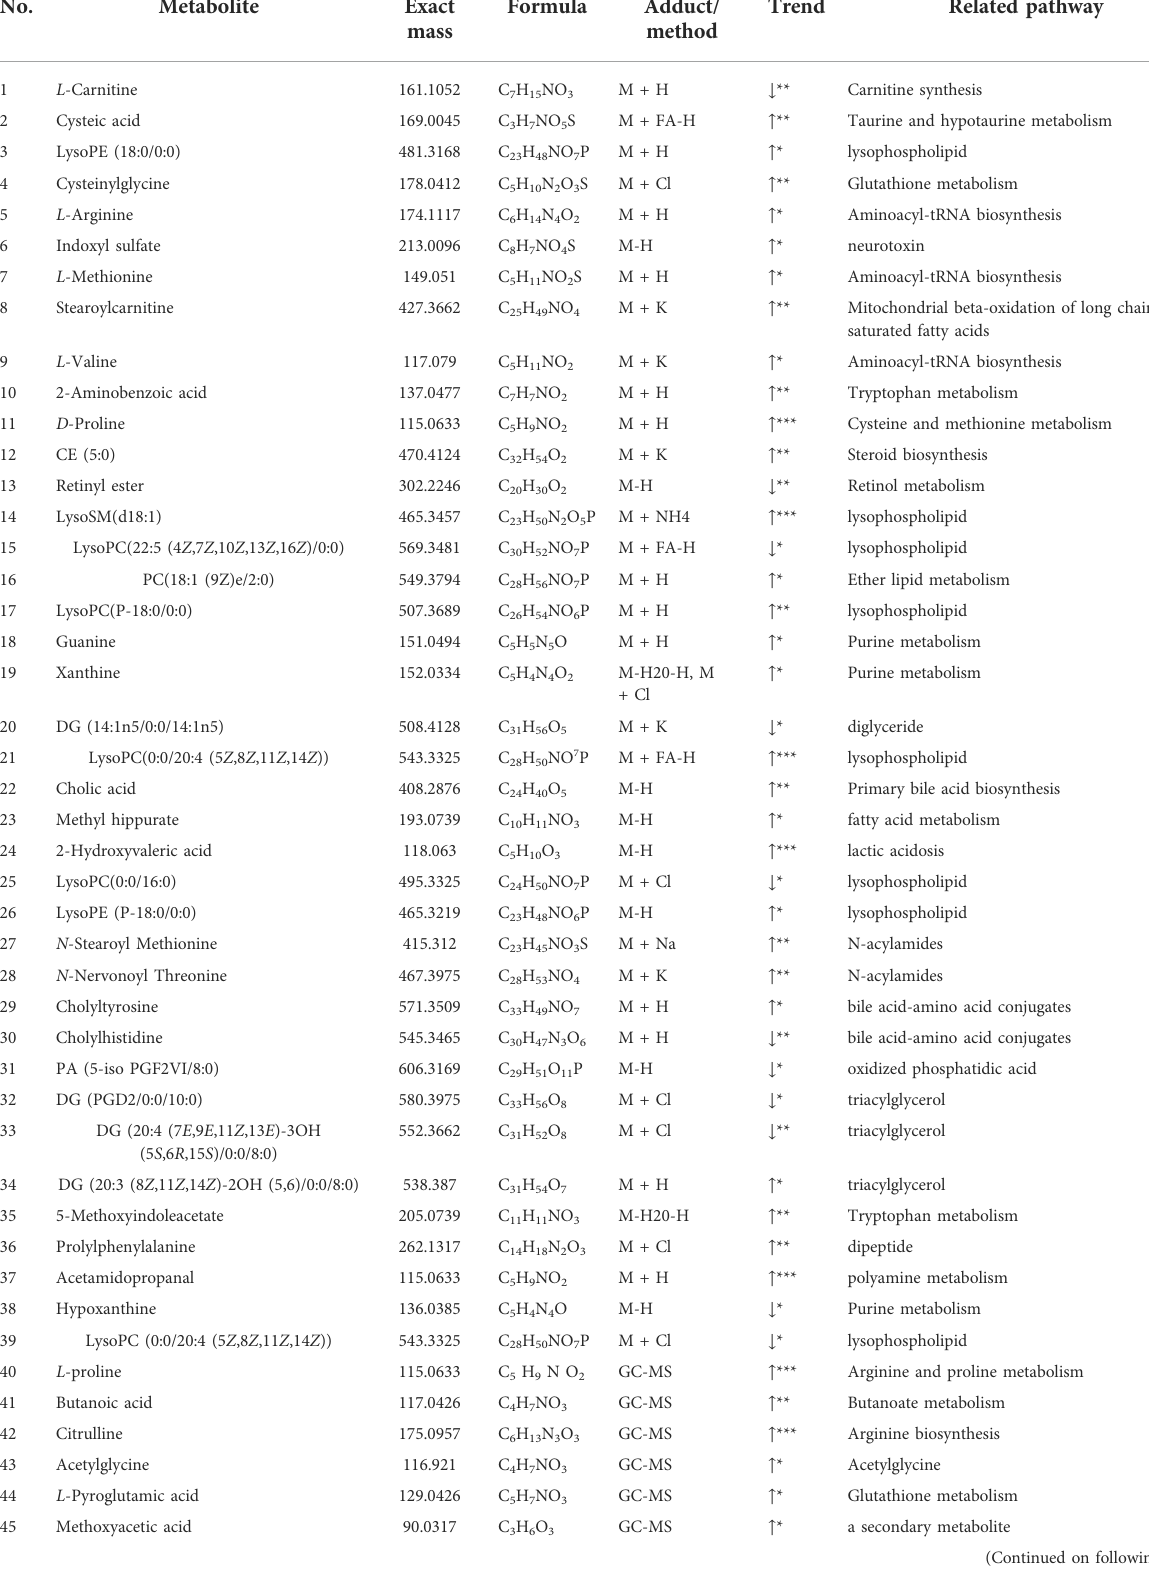
TABLE 1 Major potential biomarkers of AD model group induced by D -Gal/AlCl 3 and related metabolic pathways. No. Metabolite Exact Formula mass